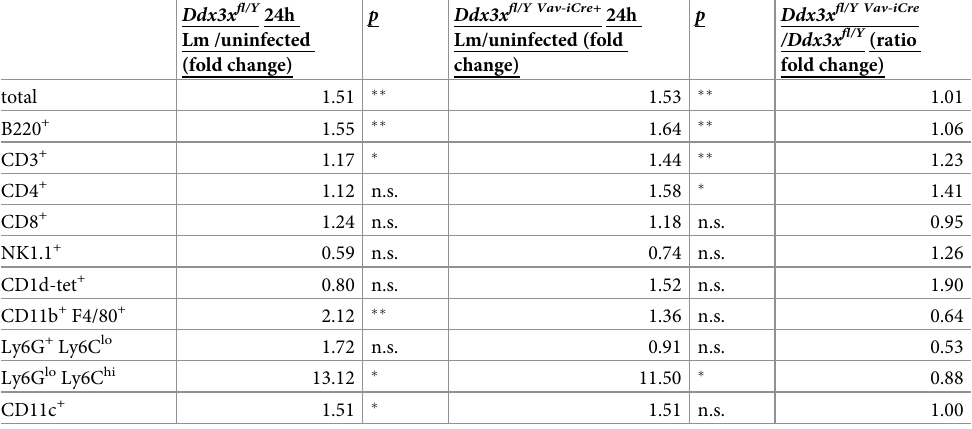
Table 1. Changes in spleen cell populations after 24h of infection with Listeria monocytogenes . Numbers in columns 2 and 4 represent relative changes of the indicated cell populations in Ddx3x fl/y and Ddx3x fl/y Vav-iCre mice, infected for 24h with L . monocytogenes (Lm). Numbers in column 6 show differences in cell population changes between the two geno- types, expressed as the ratio Ddx3x fl/y Vav-iCre /Ddx3x fl/y . P values in columns 3 and 5 indicate whether any changes between uninfected and infected mice reached statistical significance; � P < 0.05, �� P <